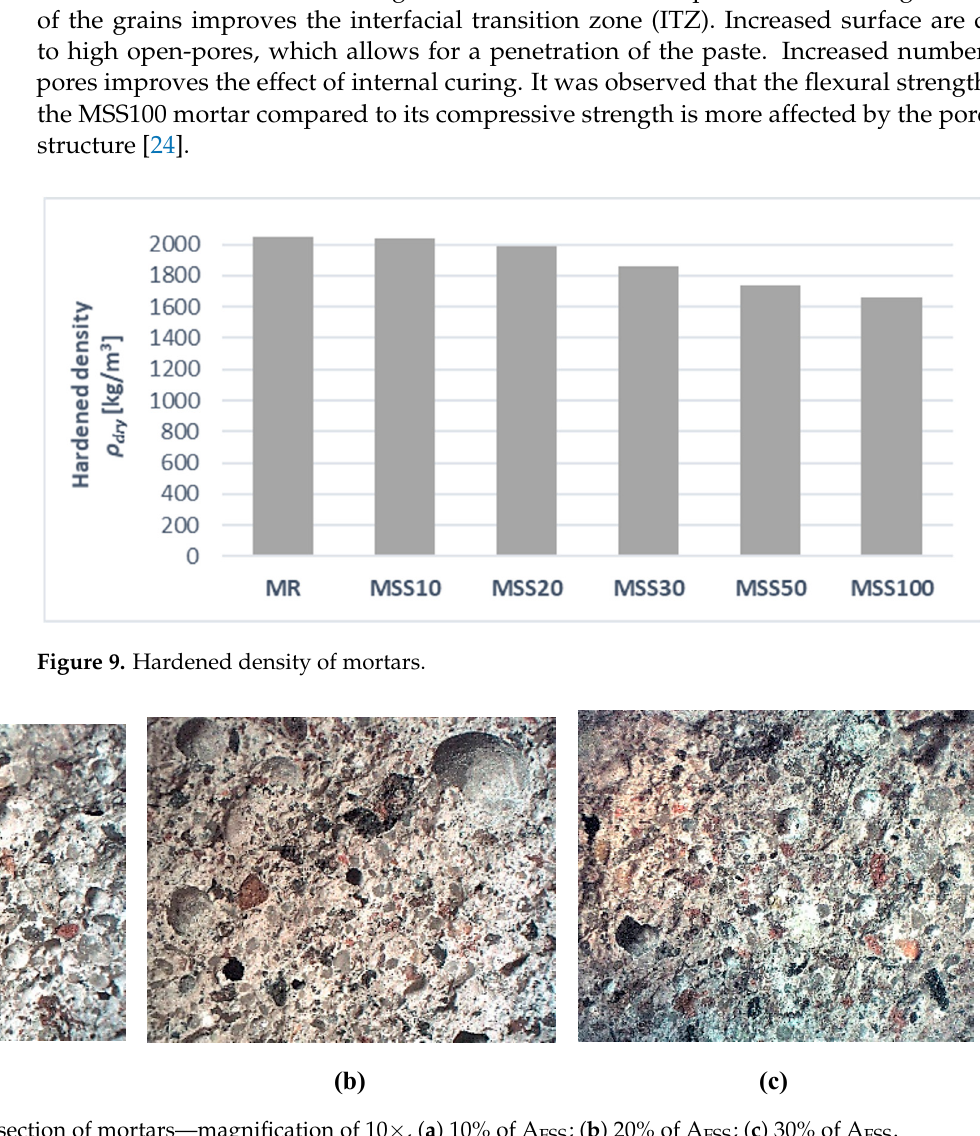
FSS ; ( b ) 20% of A FSS ; ( c ) 30% of A FSS